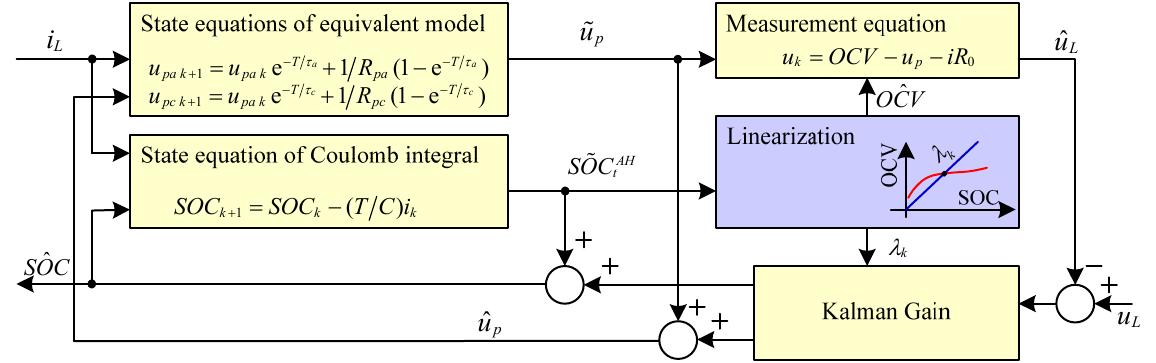
Figure 15. Principle of SOC estimation method using Kalman filter based on local